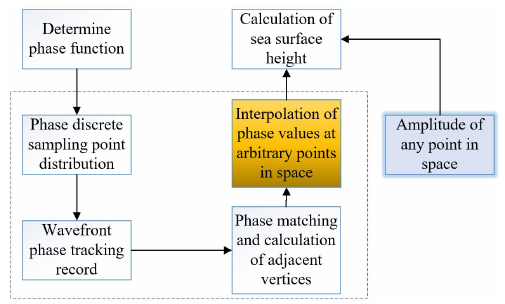
Figure 2. Flow of phase interpolation and height